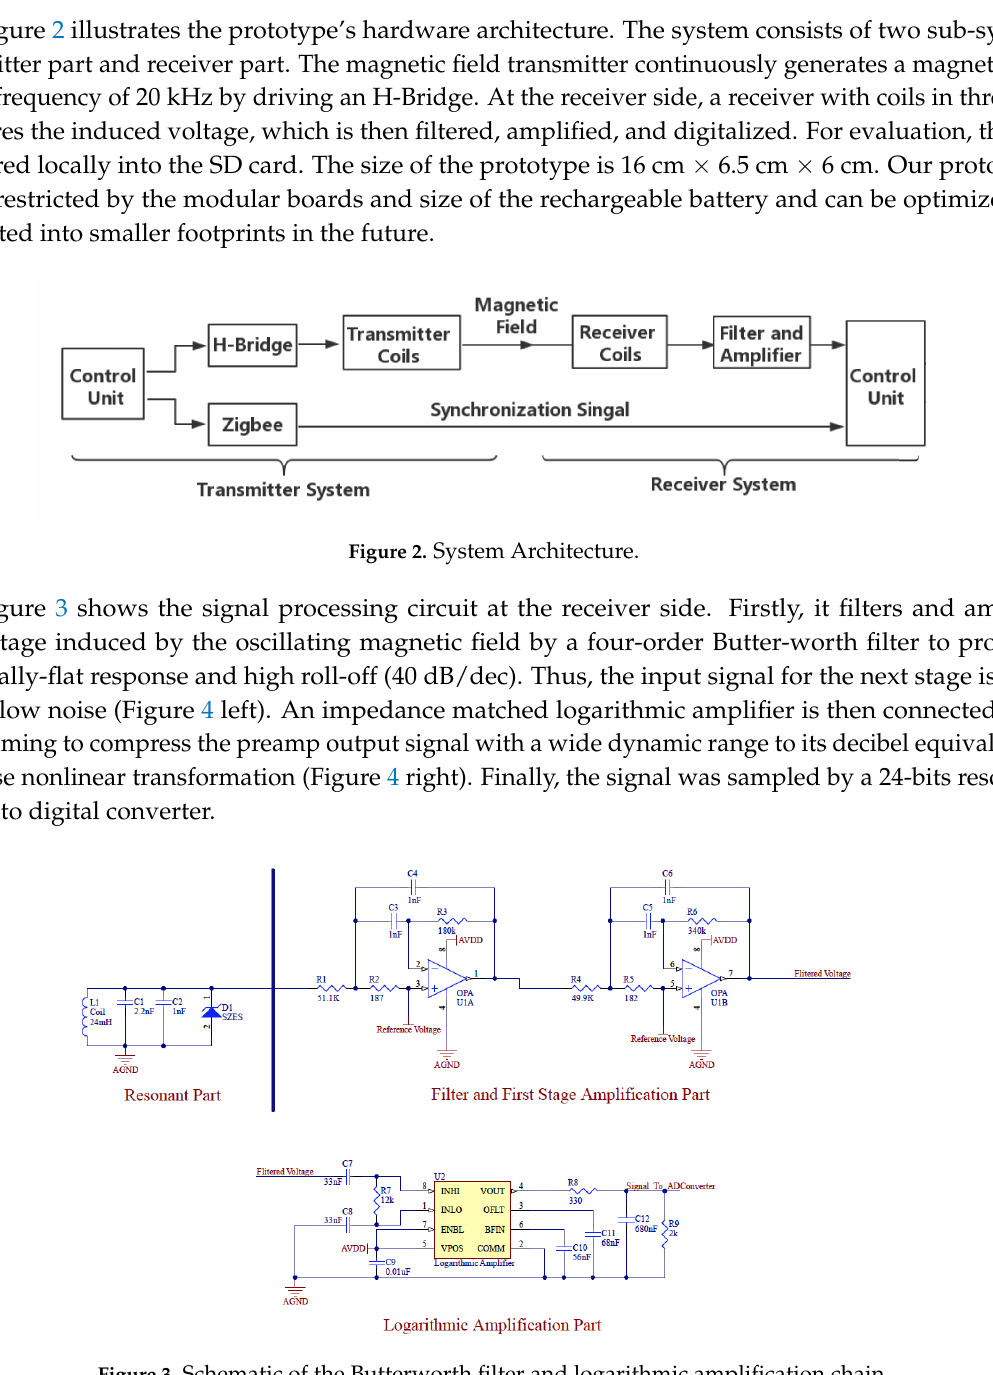
Figure 3. Schematic of the Butterworth filter and logarithmic amplification